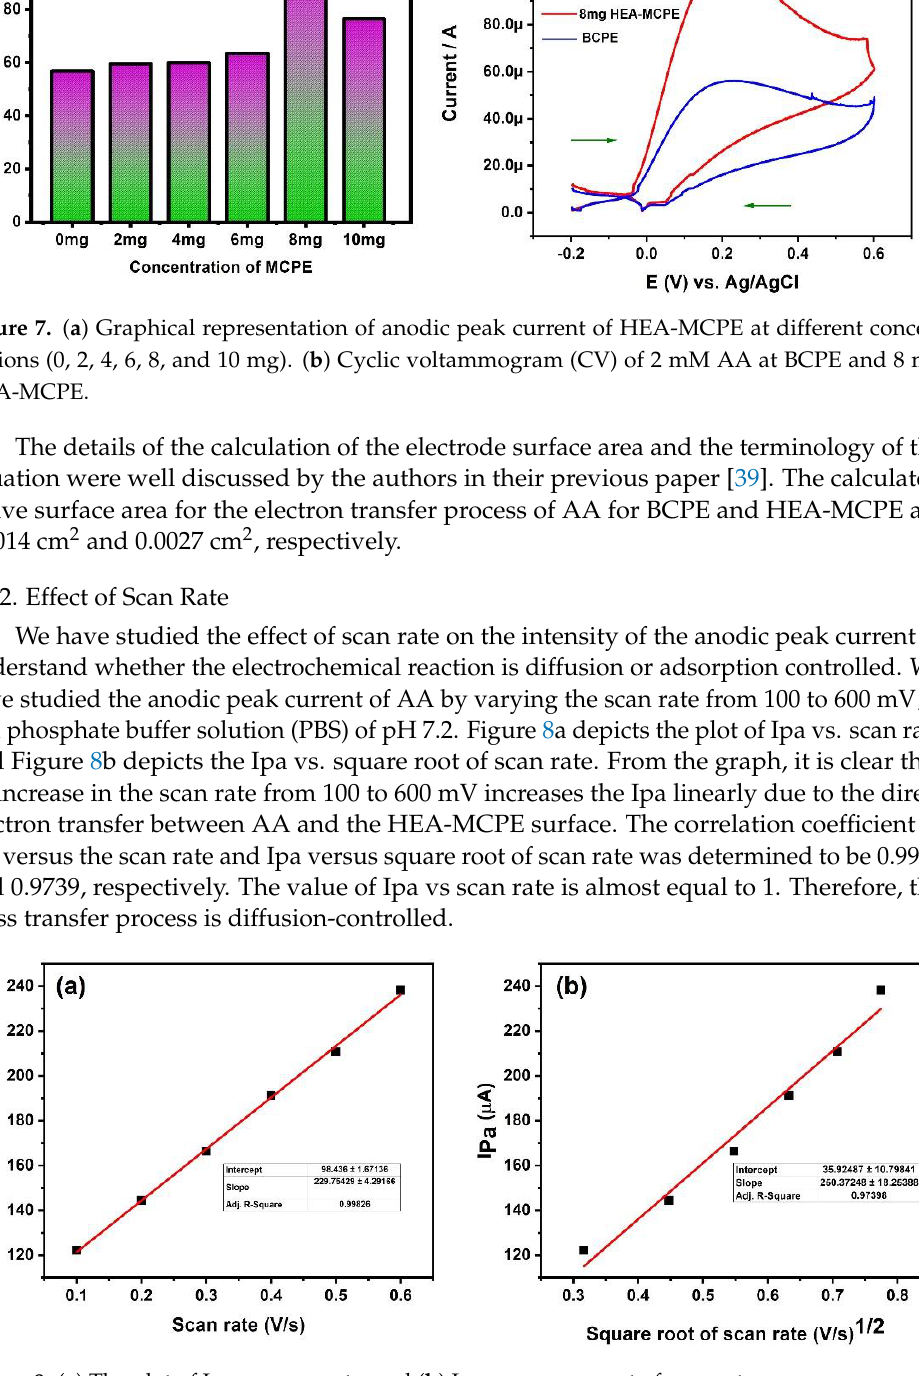
Figure 8. ( a ) The plot of Ipa vs. scan rate, and ( b ) Ipa vs. square root of scan rate.